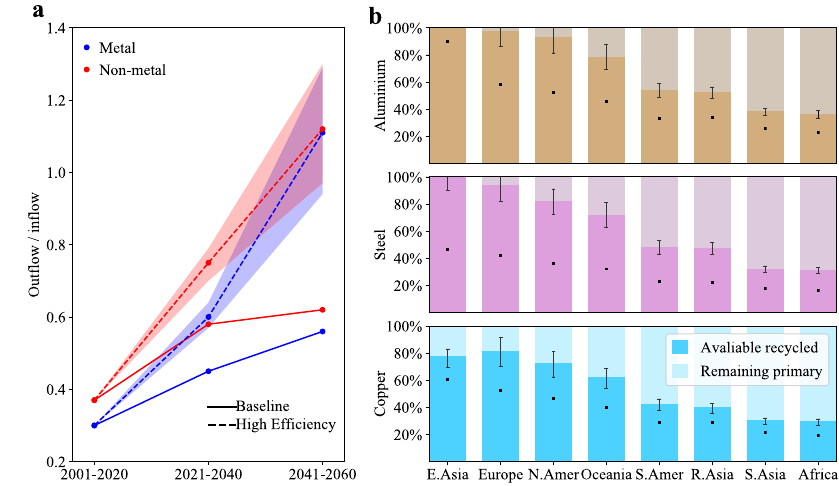
Fig. 4 The potential for closing building material cycles. a Change in out fl ow-to-in fl ow ratios over time (in 2001 – 2020, 2021 – 2040, and 2041 – 2060, respectively) under two scenarios. The shaded bands represent the sensitivity intervals of out fl ow-to-in fl ow ratios in the High Ef fi ciency (HE) scenario (given by 20 percentage point variations for each strategy, for more details see Supplementary Table 13). b Share of recycled output in total input for aluminum, steel, and copper, respectively, during 2021 – 2060 in eight global regions (see sub-regions in the Supplementary Table 11). The whiskers represent the sensitivity intervals of the share in the HE scenario. Black dots represent the share in the Baseline